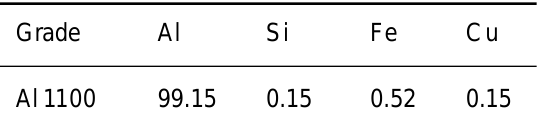
Table 1. Chemical composition of the examined sheets, wt. %.